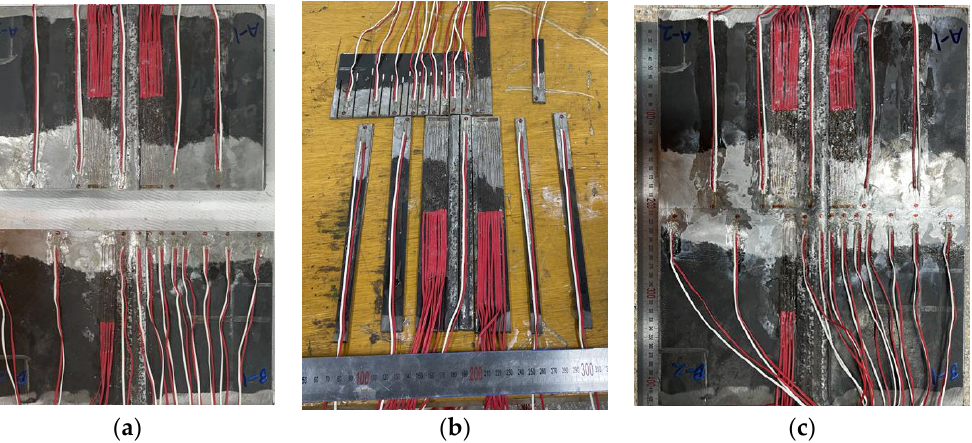
Figure 5. Cutting process to measure welding residual stress. ( a ) Initial condition; ( b ) after the first cutting; ( c ) after the second cutting.